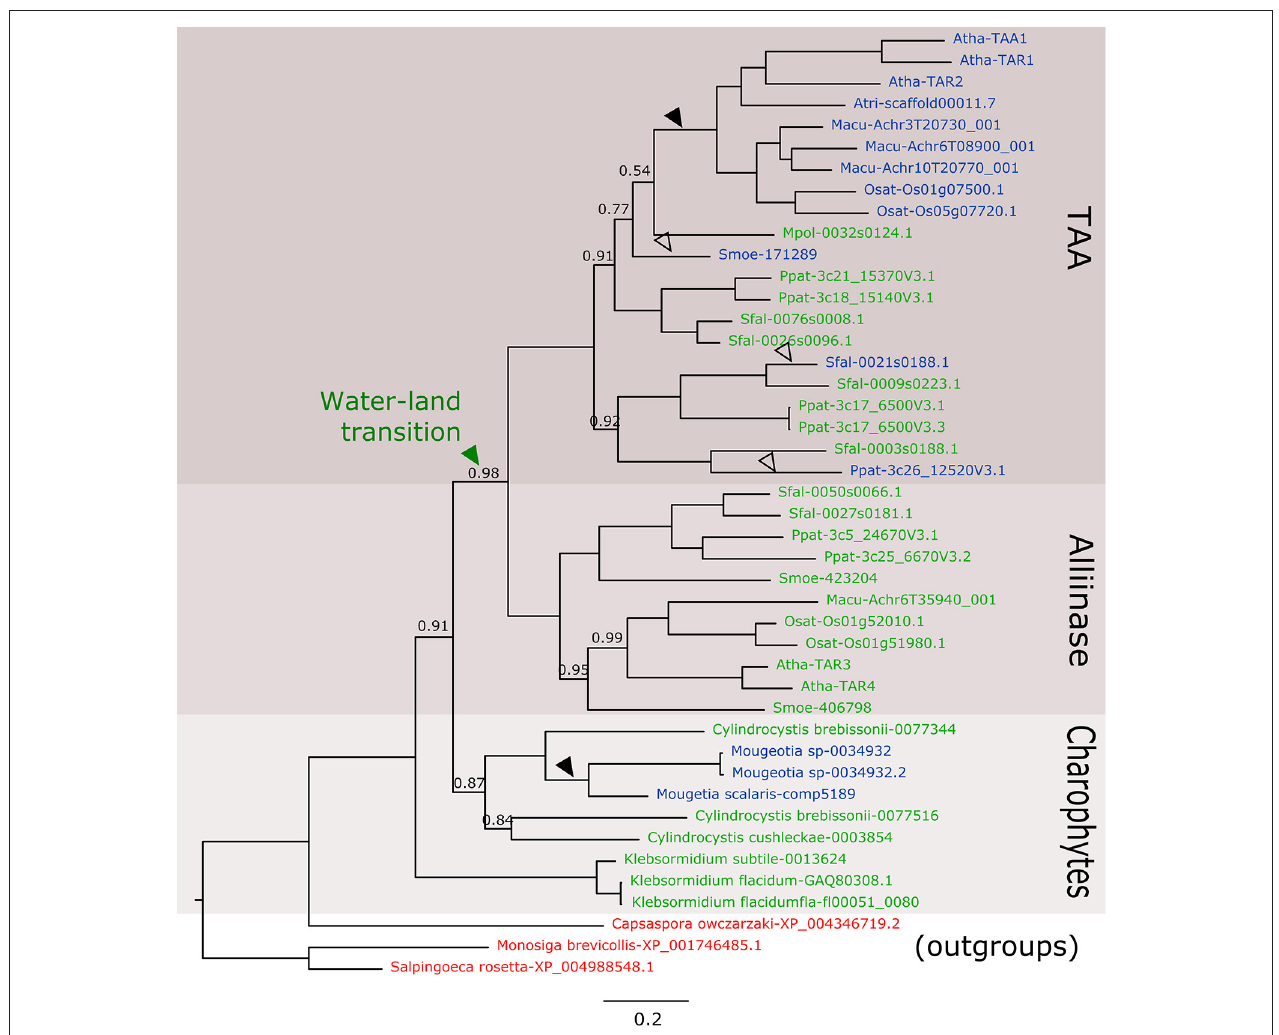
FIGURE 1 | Phylogenetic relationship of TAA-like genes from Streptophytes. Nucleotide sequences of green algae species were retrieved from 1 kp (Matasci et al., 2014) and Tree of Life Project (Cooper and Delwiche, 2016) charophytes transcriptomic assemblies and using AtTAA1 protein sequence as query for tBLASTn search. In total, 36 transcriptomic experiments were used and sequences with low similarity or with more than 50% gaps in the alignments were eliminated. Putative protein sequences and reference sequences were aligned using the MUSCLE method implemented in MEGA6 ( Tamura et al., 2013) and non-significant positions were manually eliminated. The phylogenetic tree was constructed using MrBayes ( Ronquist et al., 2012) with invgamma rate variation. 11.4 million generations were run until 1E-3 mean standard deviation was obtained. Number in nodes indicates Bayesian posterior probability values, nodes have a probability value equal to 1 are not shown. The scale bar indicates the genetic distance. Reference sequences were obtained from Phytozome (Goodstein et al., 2012). Non-plant sequences in red were retrieved from NCBI and used as outgroups to root the tree similarly to Wang et al. (2014). Sequences in green contain an alliinase domain, sequences in blue do not have the alliinase domain. Black arrows indicate the position of reliable loss events of the alliinase domain and white arrow indicate the less reliable ones. Atha, Arabidopsis thaliana ; Osat, Oryza sativa ; Macu, Musa acuminate ; Atri, Amborella trichopoda ; Ppat, Physcomitrella patens ; Some, Sellaginella moeleindorfii ; Sfal, Sphagnum fallax